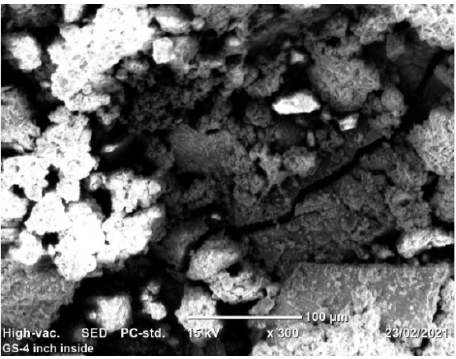
Materials 2021 , 14 , x FOR PEER REVIEW